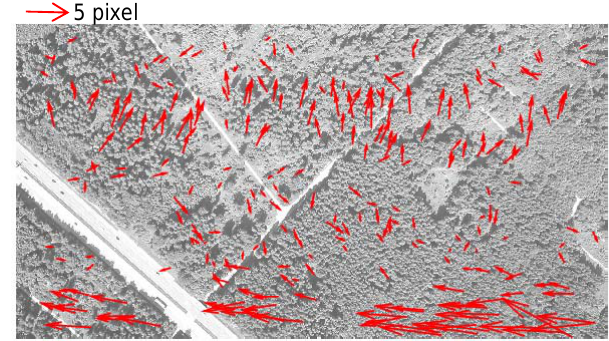
Figure 8: Image distortions between two consecutive 4k video frames if the helicopter hoovers. Arrows show the positional difference after projective transformation.